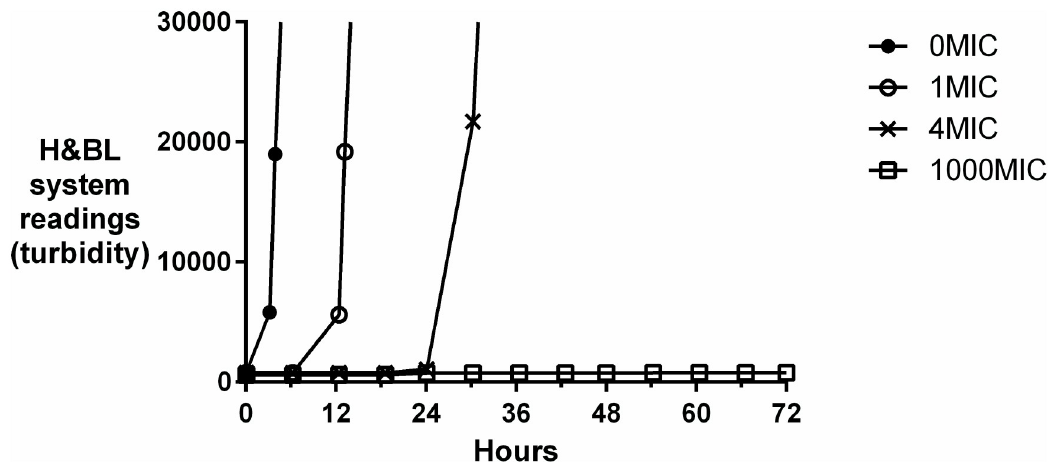
Fig 3. HB&L system readings over time in a single experiment set in which E . coli was exposed to increasing MICs of gentamicin, resulting in increased delay in exponential bacterial growth in 1MIC and 4MIC, while no growth was demonstrated at 10 3